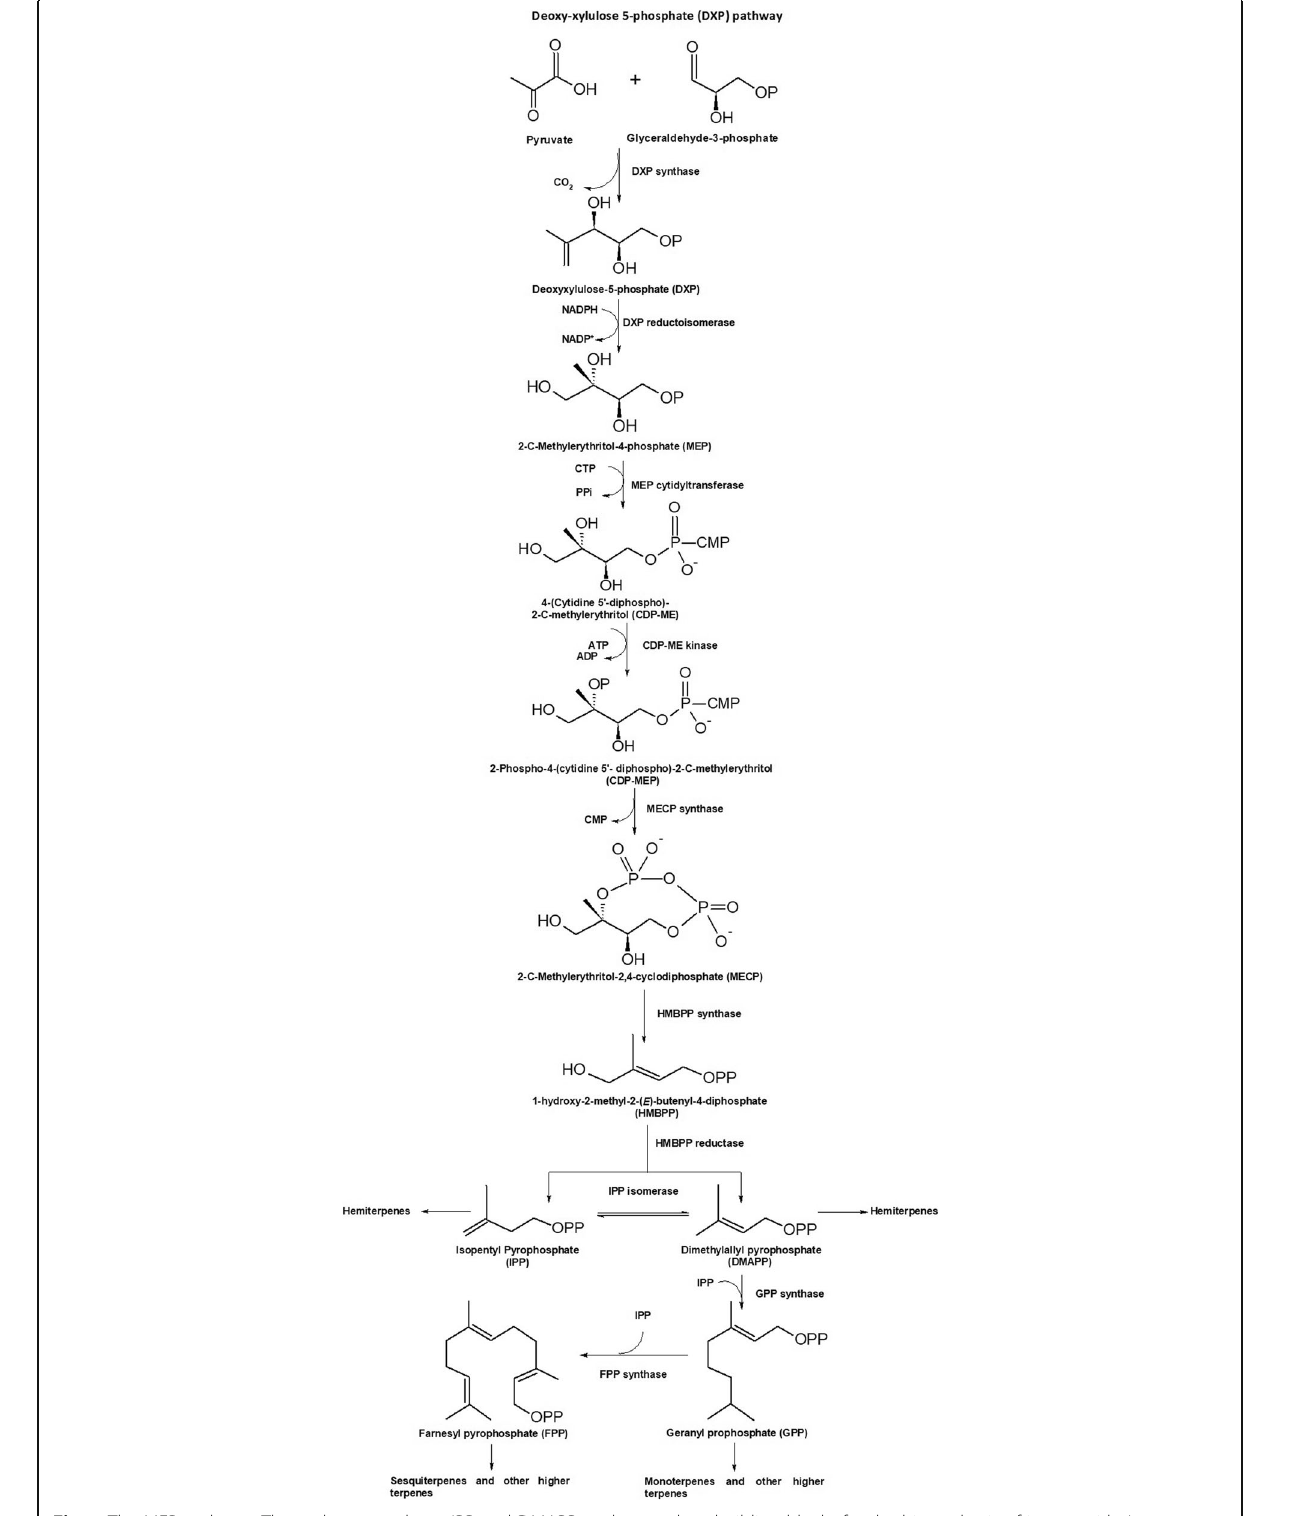
Fig. 1 The MEP pathway. The pathway produces IPP and DMAPP as the 5-carbon building blocks for the biosynthesis of isoprenoids. It condenses glyceraldehyde 3-phopshate and pyruvate through DXS and forms IPP and DMAPP through six added steps. DMAPP linkage with one or two molecules of IPP forms monoterpene or sesquiterpene,